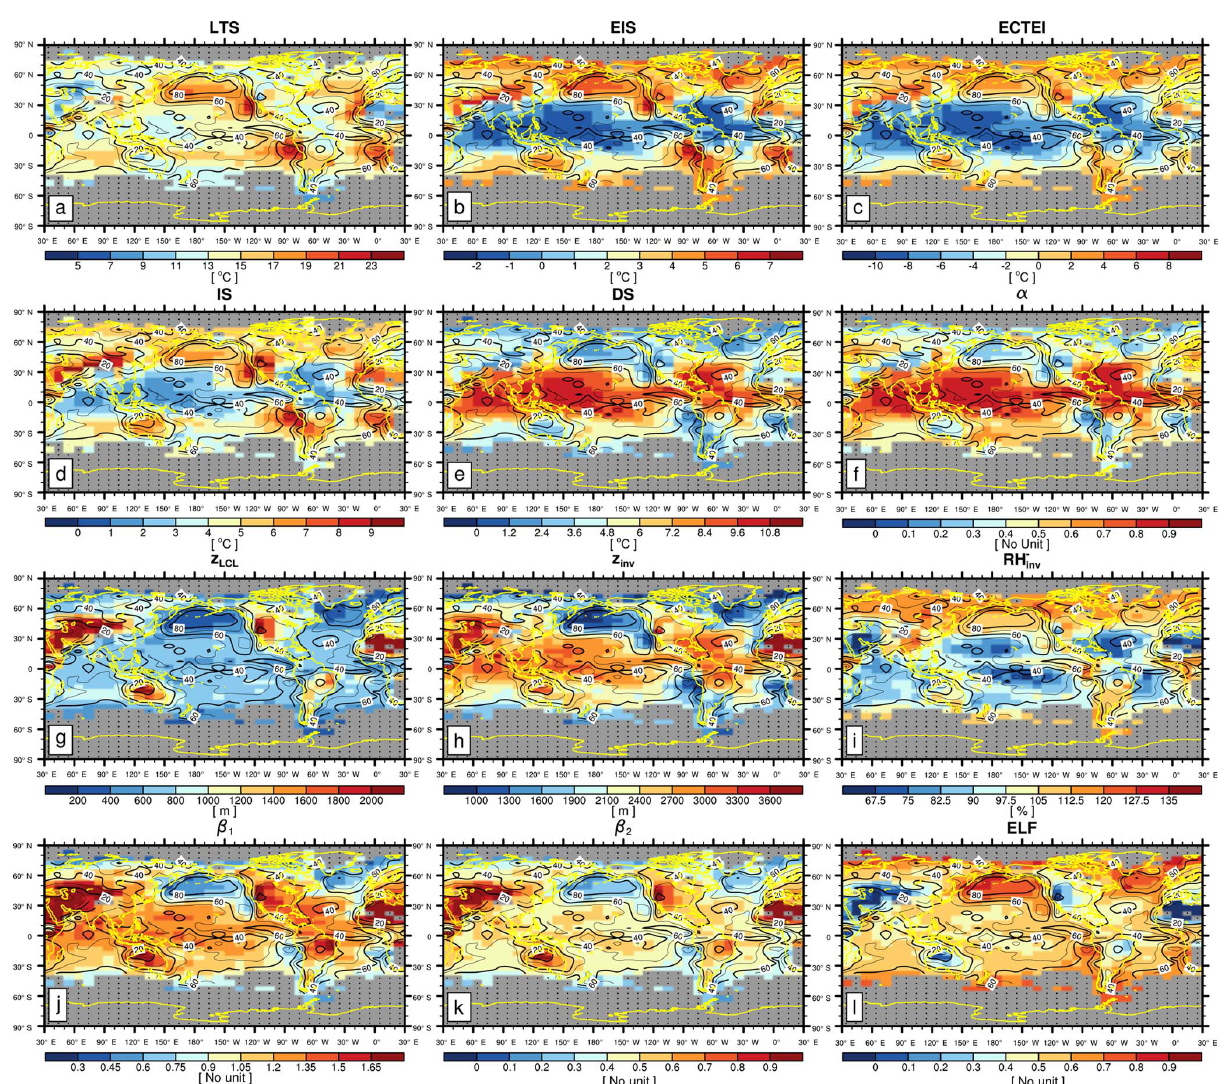
Figure 3. Global distribution of climatological (a) lower-tropospheric stability (LTS), (b) estimated inversion strength (EIS), (c) estimated cloud-top entrainment index (ECTEI), (d) inversion strength (IS), (e) decoupling strength (DS), (f) decoupling parameter ( α ), (g) lifting condensation level of near-surface air ( z LCL ), (h) inversion height ( z inv ), (i) relative humidity at the inversion base (RH − low-level cloud suppression parameter ( β 1 ), (k) the second low-level cloud suppression parameter ( β 2 ), and (l) estimated low-level cloud fraction (ELF) in June–July–August (JJA). The contour line denotes the climatological LCA in JJA reported by surface observers. The grid boxes with a climatological observation number below 100 in JJA are masked by gray color and dots. Only the data satisfying 0 < α < 1 are used for this